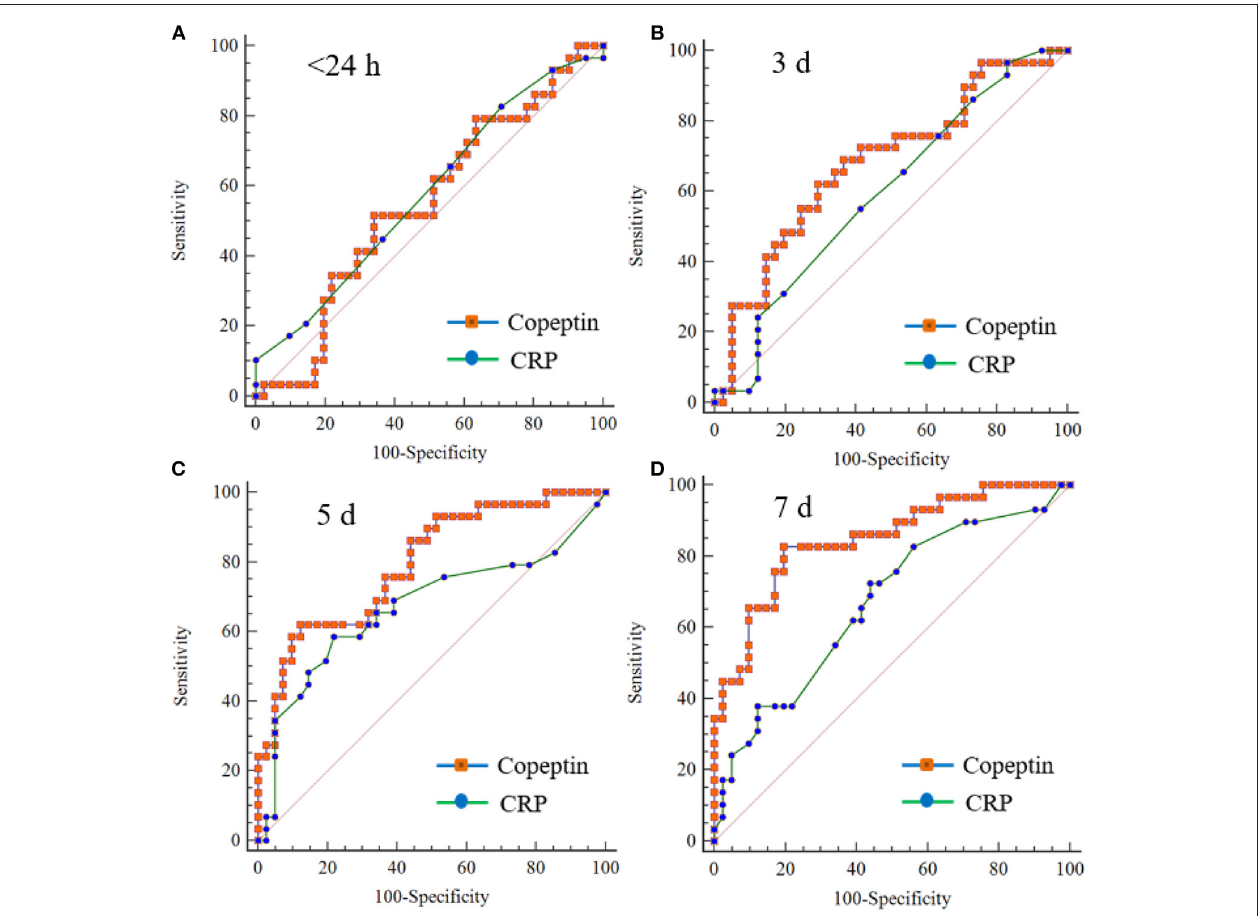
FIGURE 3 | Comparison of receiver operating characteristic (ROC) curves between copeptin and CRP for predicting 6-month poor outcome in patients with moderate TBI. There is no significant difference in the comparison values between copeptin and CPR measured on within 24h (A) , day 3 (B) , and day 5 (C) . The values measured on the 7th day (D) were statistically different (AUROC difference: 0.179, SE: 0.074, 95% CI : 0.032–0.325; p = 0.016). AUROC, area under the ROC curve; CI , confidence interval; and SE, standard